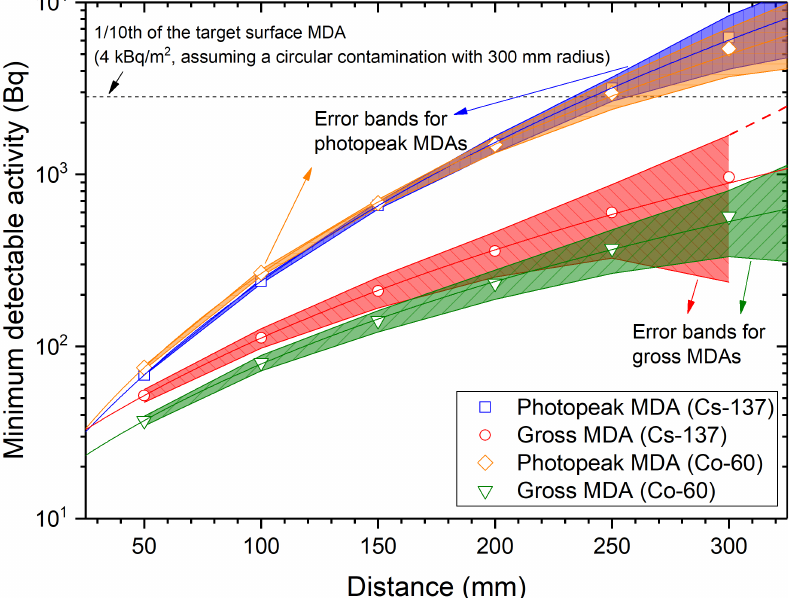
Figure 12. Minimum detectable activity for the photopeak and gross minimum detectable activ- ity